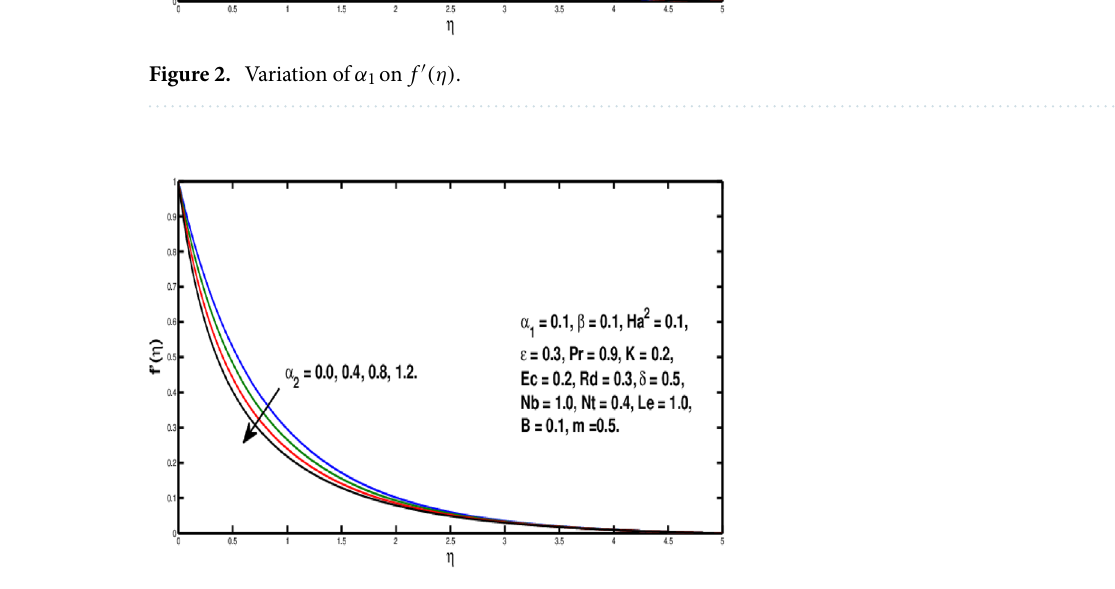
Figure 3. Variation of α 2 on f ′ (η) .